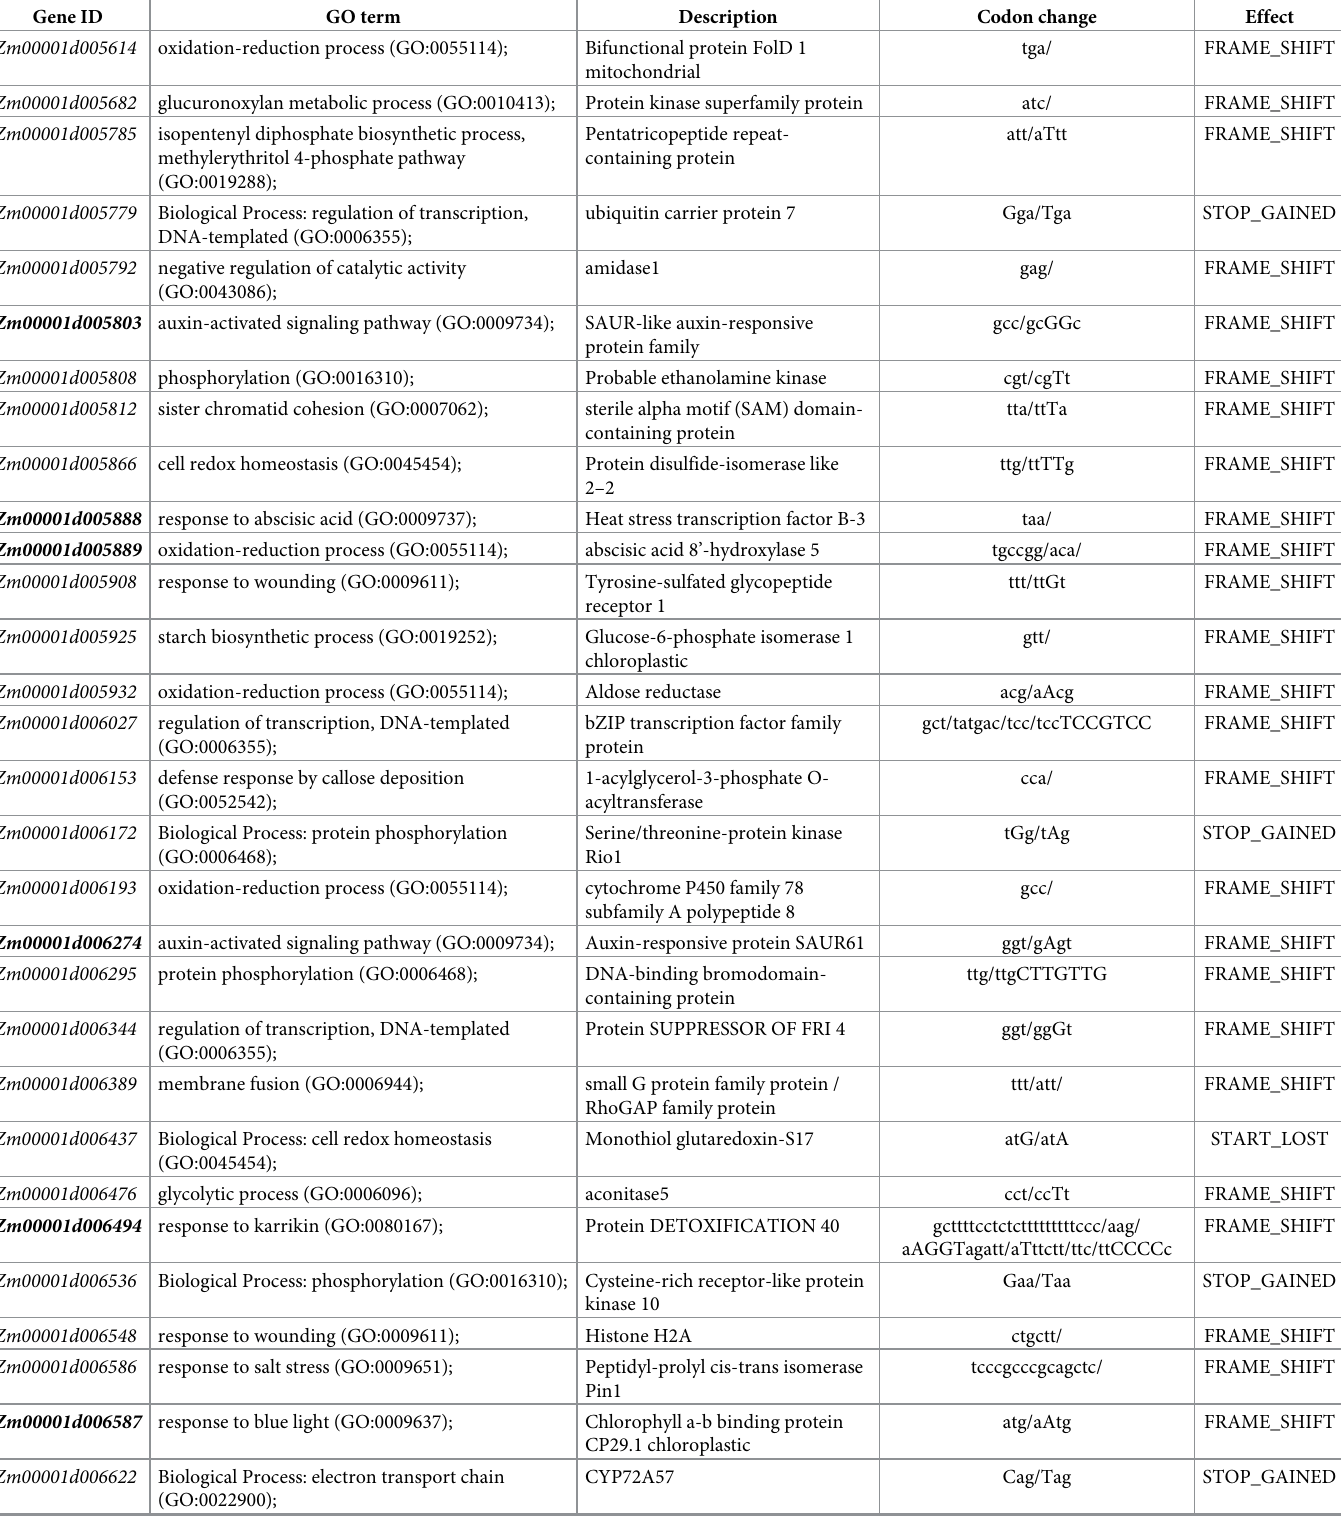
Table 3. Selected candidate genes of leaf angle in qLA02-01 with mutations in the CDS